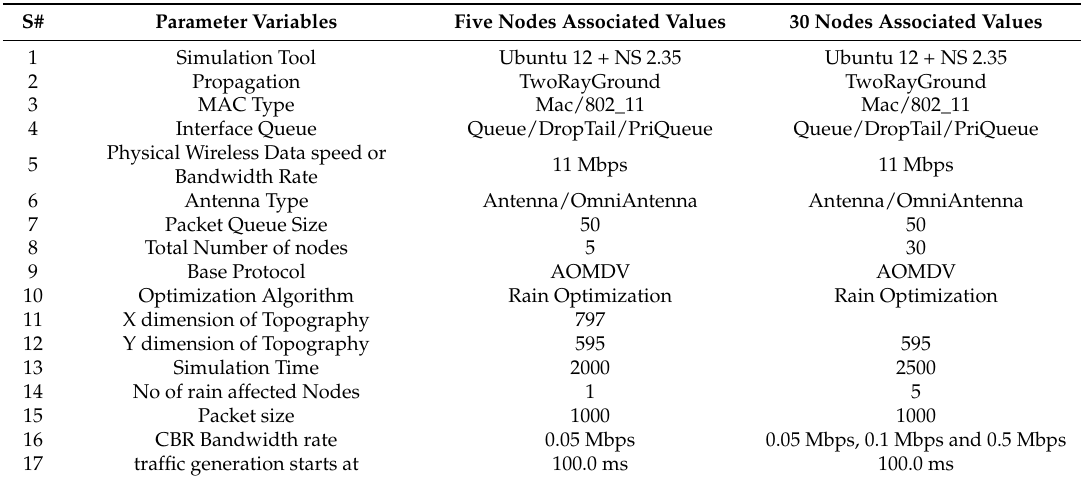
Table 3. Simulation Scenario